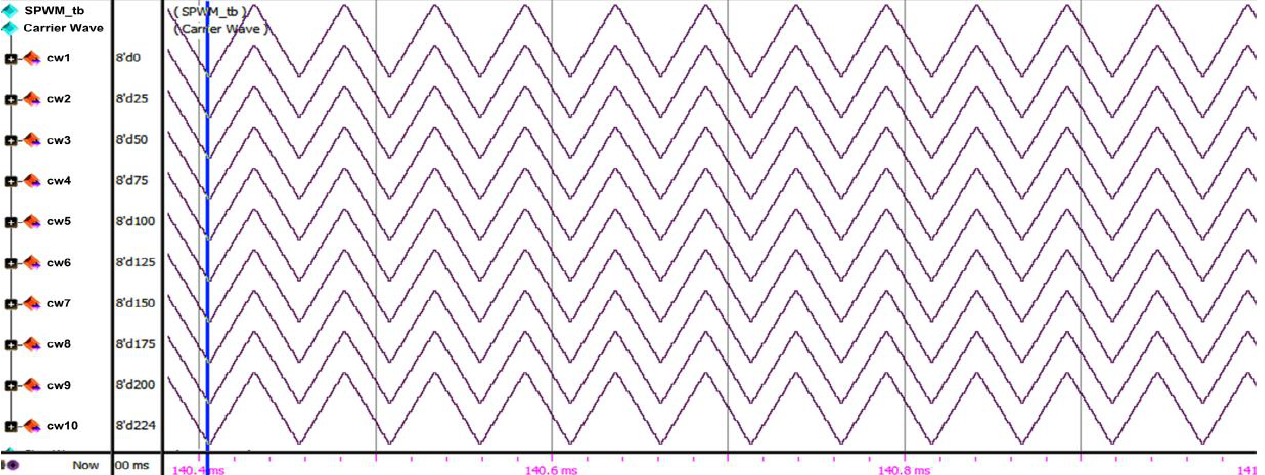
Figure 19. RTL simulation result for the ten carrier-wave (cw1 to cw10) generations of the SPWM digital switching